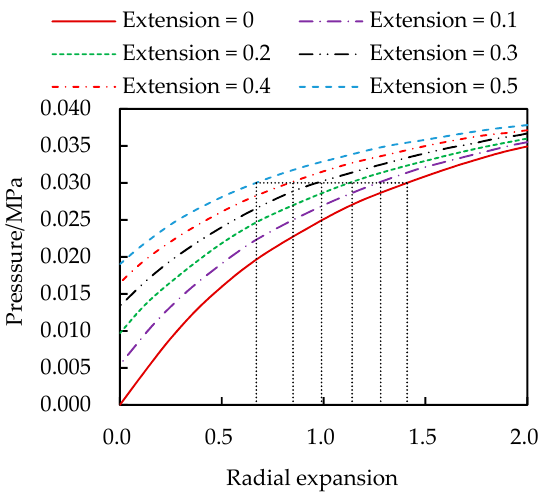
Figure 5. Axial load vs. radial expansion and axial extension.